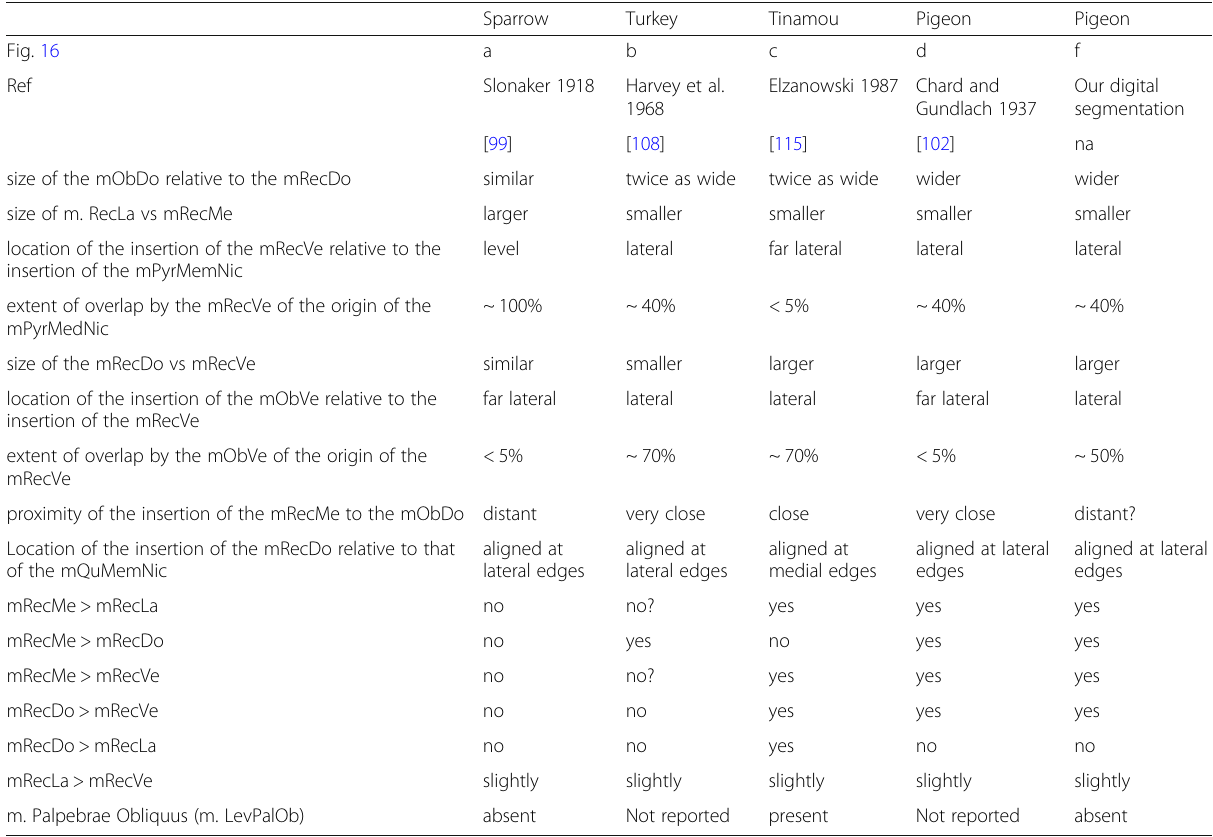
Table 4 Morphological traits among the eye muscles of birds. Size comparisons for the rectus muscles are mainly based on their size at the point of insertion Sparrow Pigeon Fig.